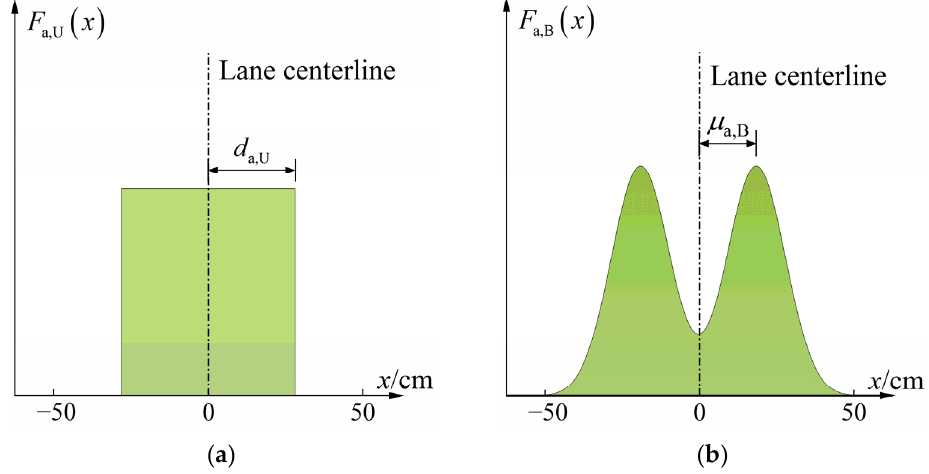
Figure 11. PDF of transverse distribution of autonomous vehicles: ( a ) Pattern 1; ( b ) Pattern 2.